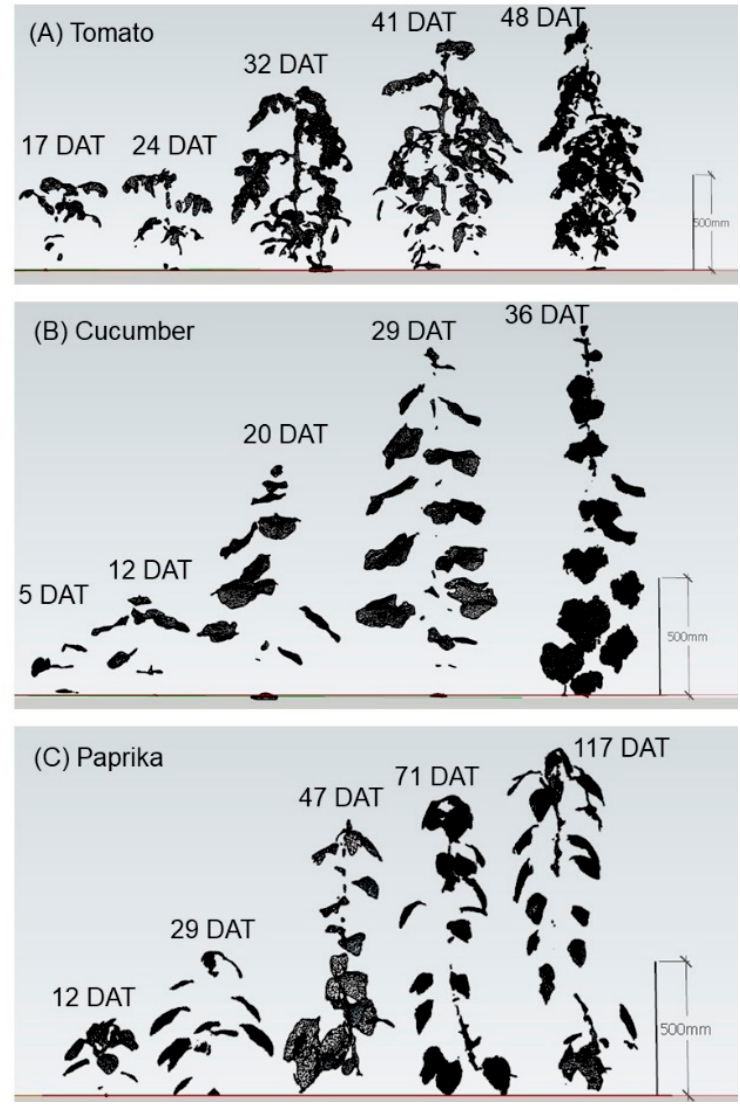
Figure 3. Surface model of individual plants to estimate leaf area, dry weight, and plant height.